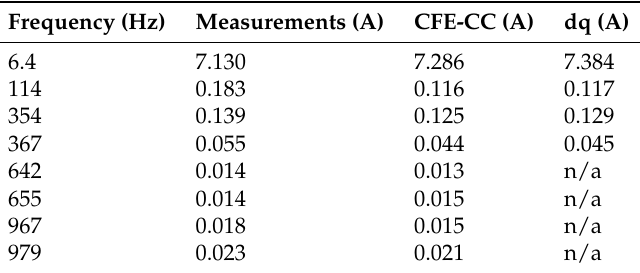
Table 5. Main frequency components in rotor current.